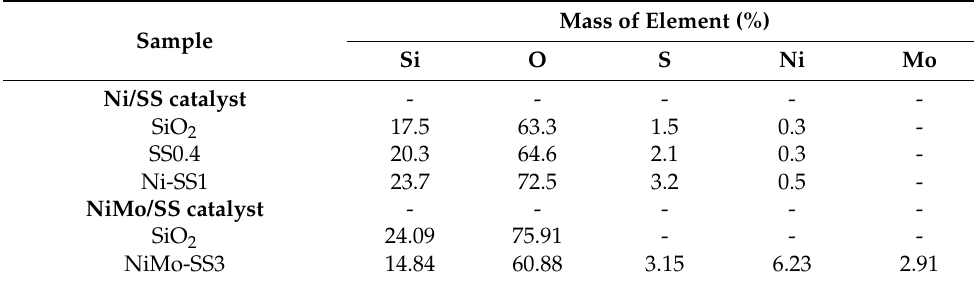
Table 2. EDX of the elements present in the